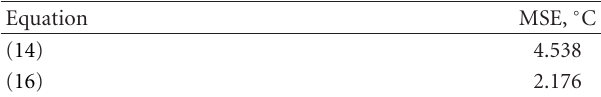
Figure 13: Water temperature values and residuals, experiment with standardization (weekly average values). Table 6: Mean square error values. Weekly average data.